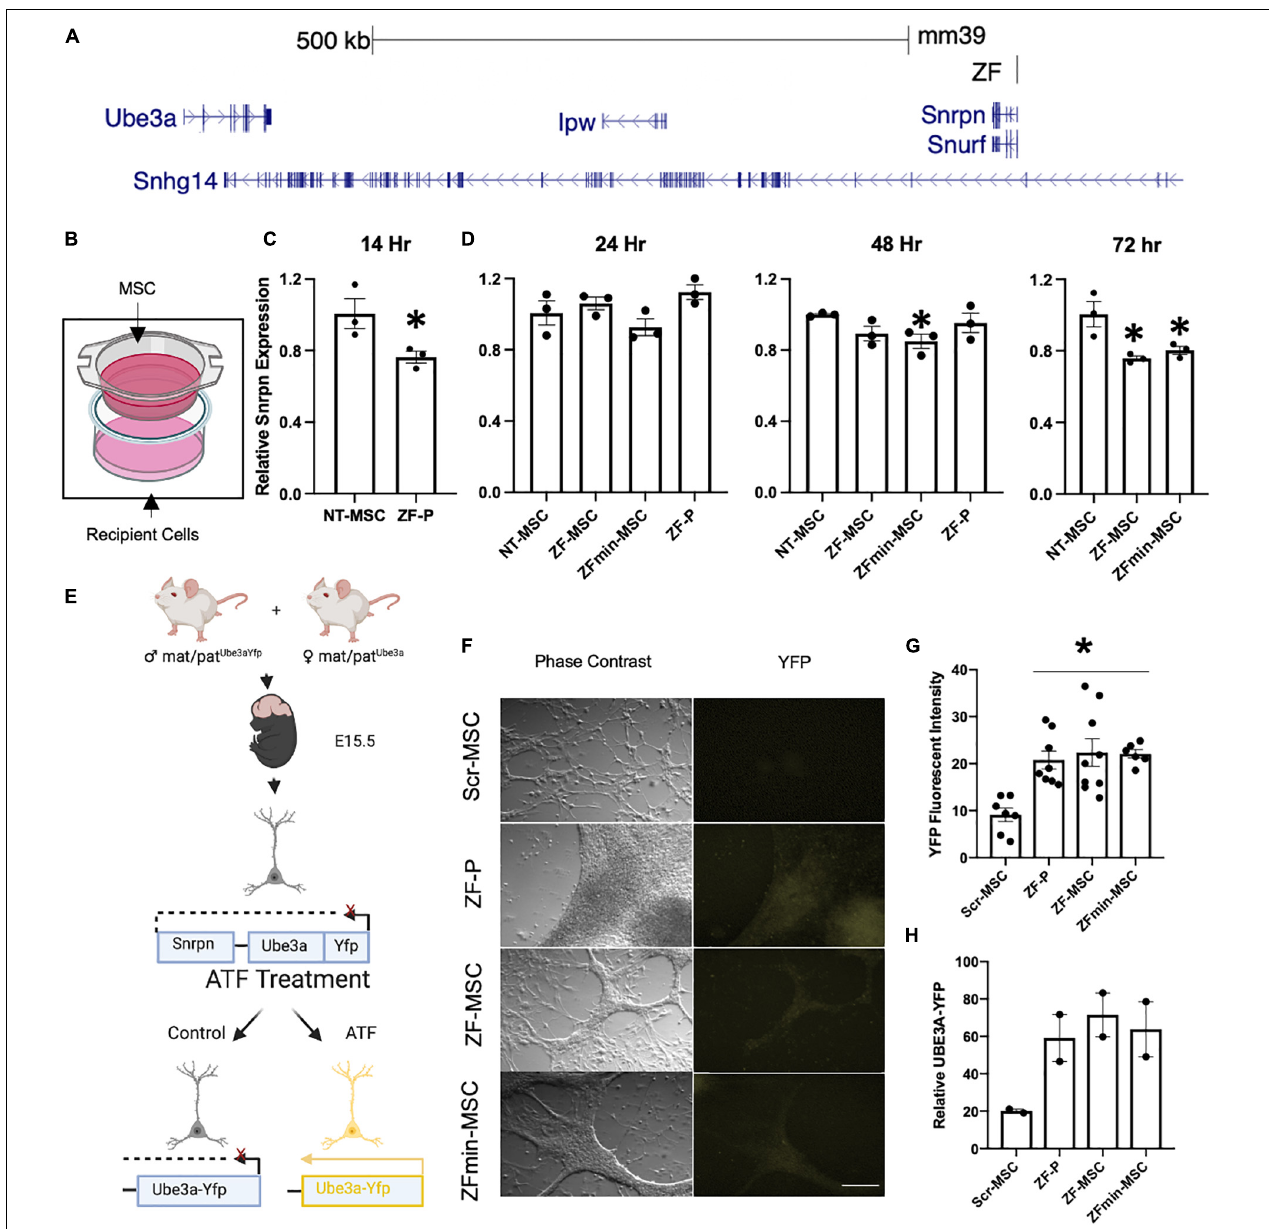
FIGURE 2 | Secreted ZF protein demonstrates transcriptional effect in genes known in angelman syndrome. (A) Schematic of the ZF Binding to the putative promoter of the long non-coding RNA in the imprinted paternal Ube3a allele. (B) Schematic of transwell experiment, ZF-MSCs are seeded in the upper Transwell basket while recipient Neuro2As are seeded in the bottom well. (C,D) The efficacy of secreted ZF from MSC to repress Snrpn was assessed longitudinally in Neuro2a cells as measured by RT-qPCR. Each dot is representative of independent well. n = 3 independent wells per group. (C) An observable reduction of Snrpn expression was observed following a 14 h incubation with 100 µ g purified ZF-P as a positive control for Snrpn , Student T -test, * p < 0.05 to NT-MSC repression. (D) An amelioration of ZF-P repression of Snrpn is observed by 24 h whereas ZF-MSC and ZFmin-MSC co-incubated groups demonstrate an observable decline of Snrpn expression over 48 h, [ F ( 3 , 8 ) = 2.738] * p < 0.05 to NT-MSC, to 72 h, [ F ( 2 , 6 ) = 9.225], * p < 0.05 to NT-MSC. (E) Schematic of experimental design for screening ZF in primary cortical neurons derived from E15.5 Ube3a + / yfp pups. Successful interference of long non-coding RNA transcription activates paternally silent Ube3a yfp . (F) Immunocytochemistry panel of representative Ube3a + / yfp primary cortical neurons shows activation of UBE3A-YFP (yellow) following incubation 24 h incubation with 250 µ g of ZF-P, ZF-MSC CM, or ZFmin-MSCCM. Scale bar = 100 µ m. (G) Quantification of YFP mean fluorescent intensity from H showed a significant two-fold increase in YFP fluorescent intensity in immune-labeled Ube3a + / yfp primary cortical neurons. One-Way ANOVA [ F ( 3 , 26 ) = 7.955] followed by Fisher’s LSD, * p < 0.05 from NT-MSC. Each dot is representative of an independent well containing an isolated cortex from a Ube3a + / yfp pup. n = 7–9 wells per group. (H) Observable increases of UBE3A-YFP were visualized in western blot analysis of treated primary cortical neurons. Each dot is representative of an independent well containing an isolated cortex from a Ube3a + / yfp pup. n = 2 wells per group. Yfp, yellow fluorescent protein. ZF-P, purified ZF protein. Error bars indicate ± standard error of the